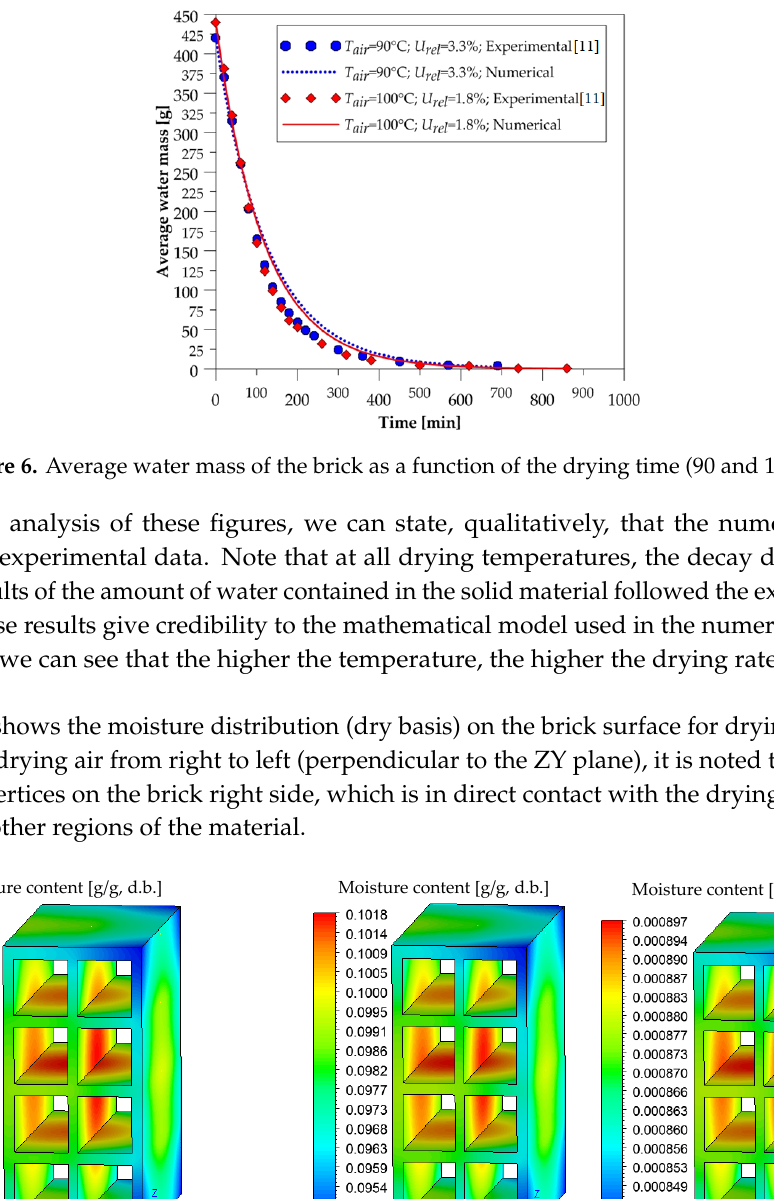
Figure 7. Moisture content distribution on the brick surface for drying at 90 °C at different durations.